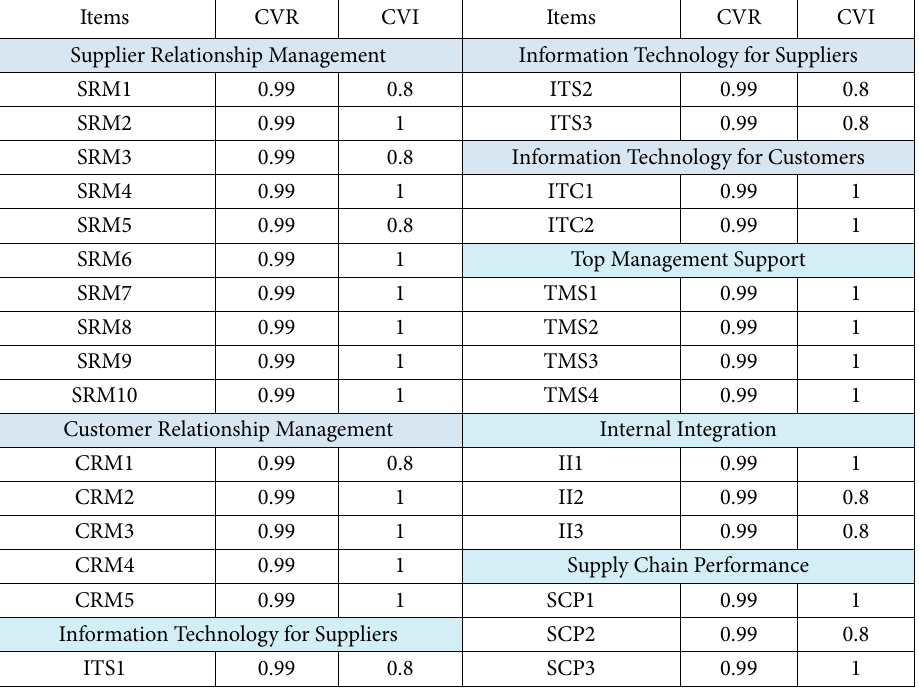
Table A2. Acceptable CVR and CVI values for